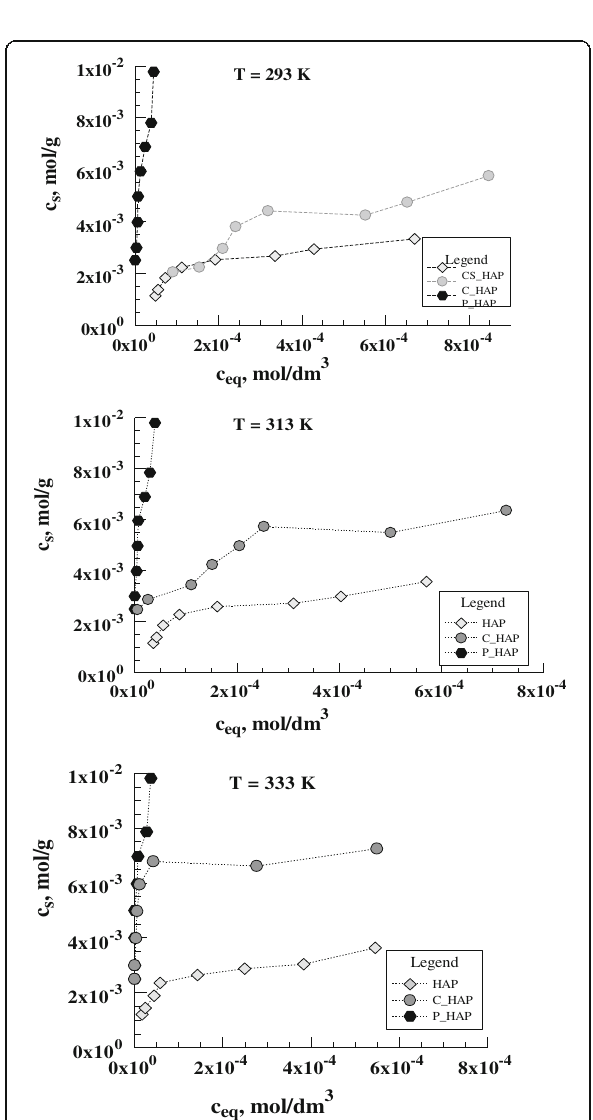
Fig. 14 The isotherms of U(VI) adsorption on HAP sorbents (pH in =6; T =293 K, 313 K, 333 K) c s concentration of U(VI) in the sorbent phase (mol/g), c eq equilibrium concentration of U(VI) in the aqueous phase (mol × dm − 3 )